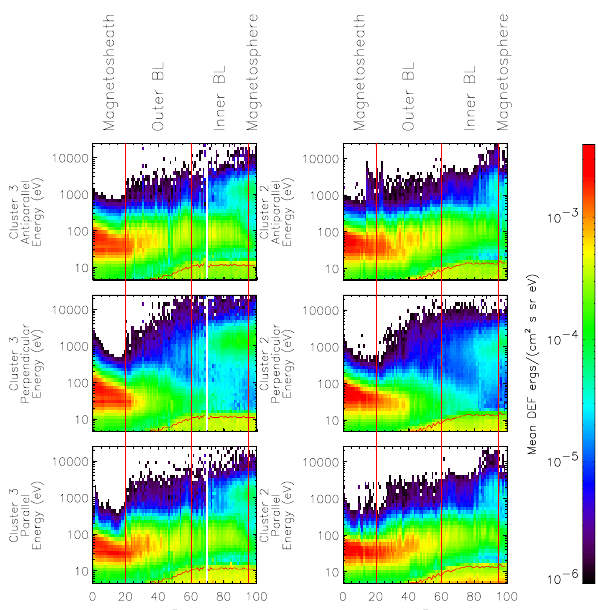
Fig. 4. Electron spectrograms from the first (Cluster 3, left-hand column) and last (Cluster 2, right-hand column) spacecraft to cross the magnetopause, reordered by transition parameter. Although the transition parameter values were derived from on-board moments from the HEEA sensors, both HEEA and LEEA data are shown in each panel. The top, middle and bottom rows show electron fluxes antiparallel, perpendicular and parallel to the magnetic field respec- tively. A stable boundary layer structure exists since there is little change between the structure observed at Clusters 3 and 2; similar structure is also observed by Clusters 1 and 4. The regions identi- fied in Sect. 2.4 (magnetosphere, inner and outer boundary layers and magnetosheath) are labelled, separated by red vertical